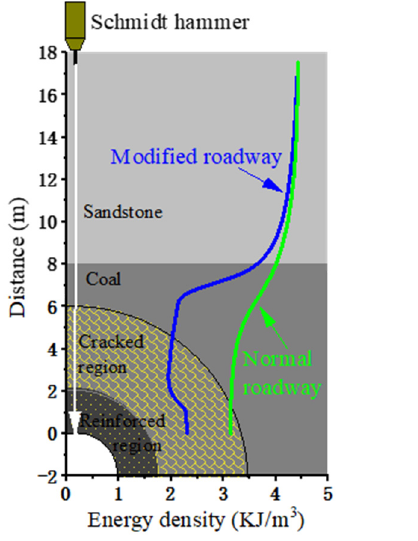
The output of elastic strain energy density along the propagation of dynamic load from the top surface to the normal and modified roadway are plotted in Figure 10a,b, respectively.